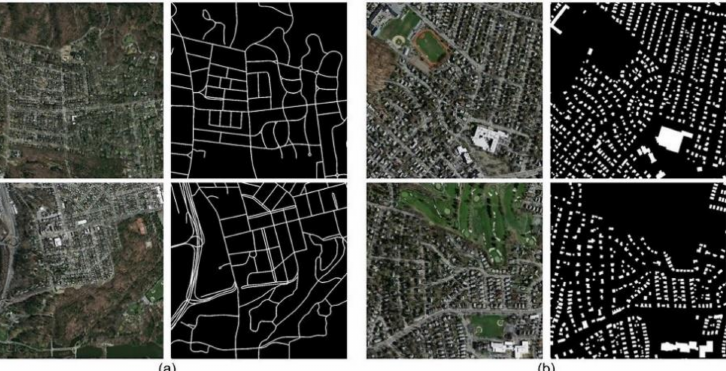
Figure 7. Samples from the Massachusetts road ( a ) and building ( b ) datasets. The RGB imagery and reference maps are displayed in the first and second columns,